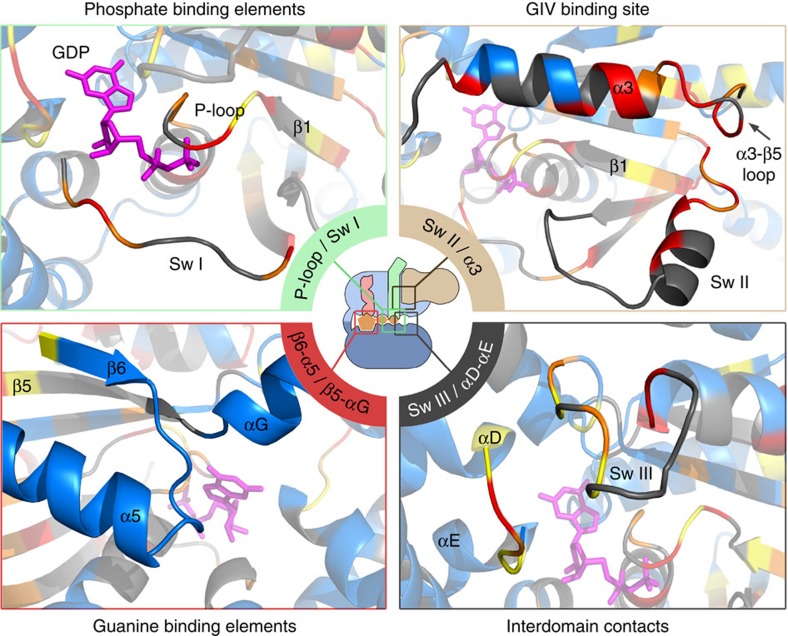
Mapping the GIV-induced NMR perturbations onto a structural model of Gαi3 in complex with the GEF motif of GIV.A model of GIV (residues 1,678–1,696) bound to Gαi3 was generated based on homology with the Gαi1/KB-752 complex38 and ab initio C-terminal extension of GIV. Residues were colour-coded for NMR perturbations as in Fig. 2. A cartoon diagram of Gα is shown in the middle and the detail of four specific regions of the structural model are enlarged: I, P-loop/Switch I, containing the G-1 and G-2 boxes that bind the nucleotide phosphates; II, Switch II/α3, corresponding to the predicted GIV-binding site on Gαi3 (Fig. 4); III, Switch III/αD-αE loop, which stabilize interdomain interactions that favour nucleotide retention; IV, β5–αG and β6/α5 loops, corresponding to the G-4 and G-5 boxes that bind the nucleotide base ring.